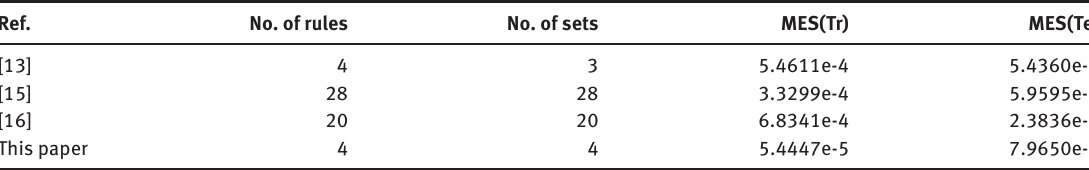
Table 3: Comparison of Performance with the Existing Models. Ref.